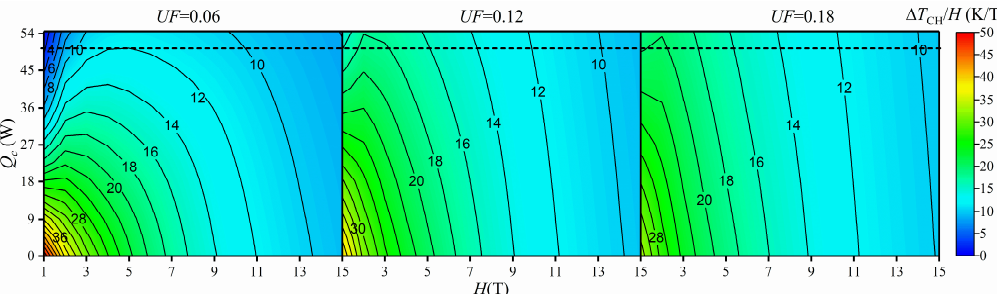
Figure 11. Cooling capacity Q c and efficiency of the magnetic field ∆ T CH / H versus magnetic field intensity under various UFs ( ν = 4.54 Hz, T h = T i = 293 K, solid line: fixed Δ T CH / H , dashed line: fixed 𝑄 (cid:3030) ).